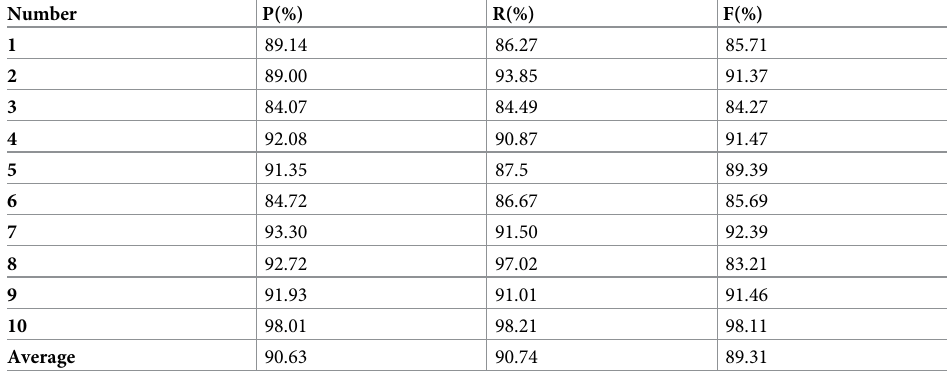
Table 2. Automatic extraction and evaluation of international cutting-edge technology recognition entities based on the SpaCy model.